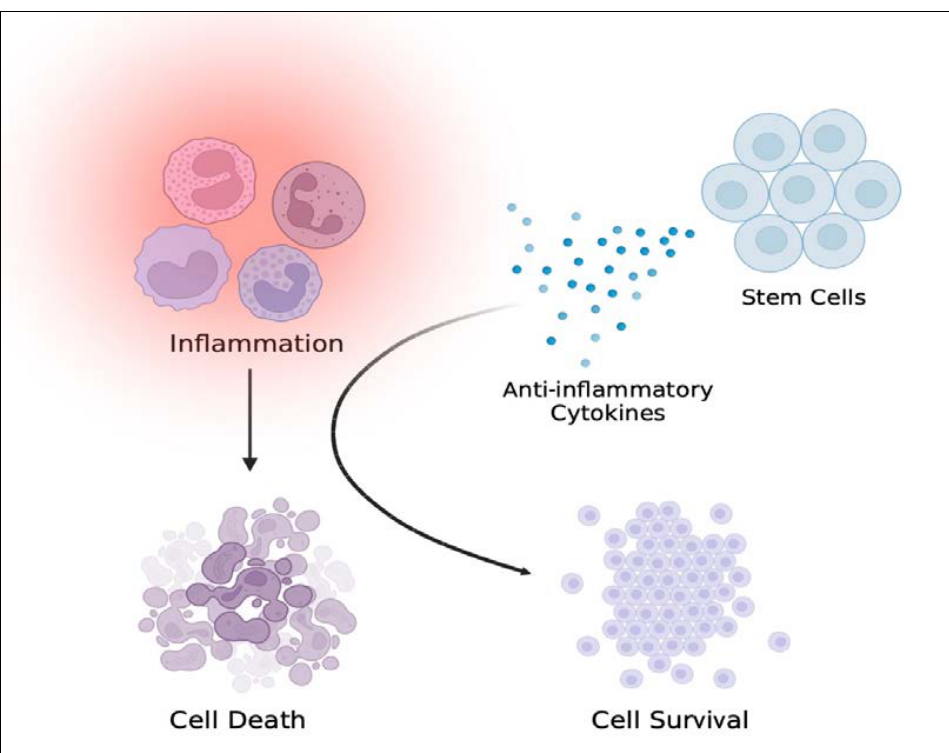
Figure 2. Inflammatory/immune cells are sequestered by stem cells that release anti-inflammatory factors suggesting the potential of stem cell therapy for treating neural injury. Figure constructed via Biorender.com.